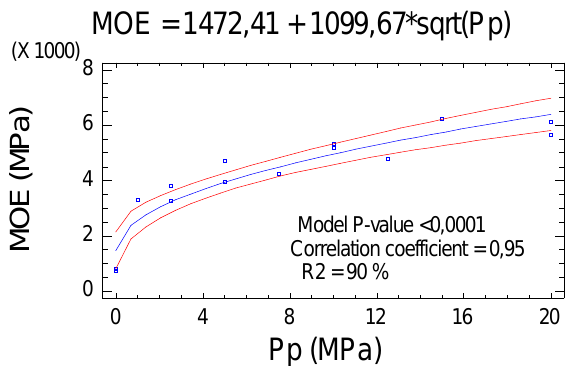
Figure 3. Influence of Pp on the modulus of elasticity (MOE).